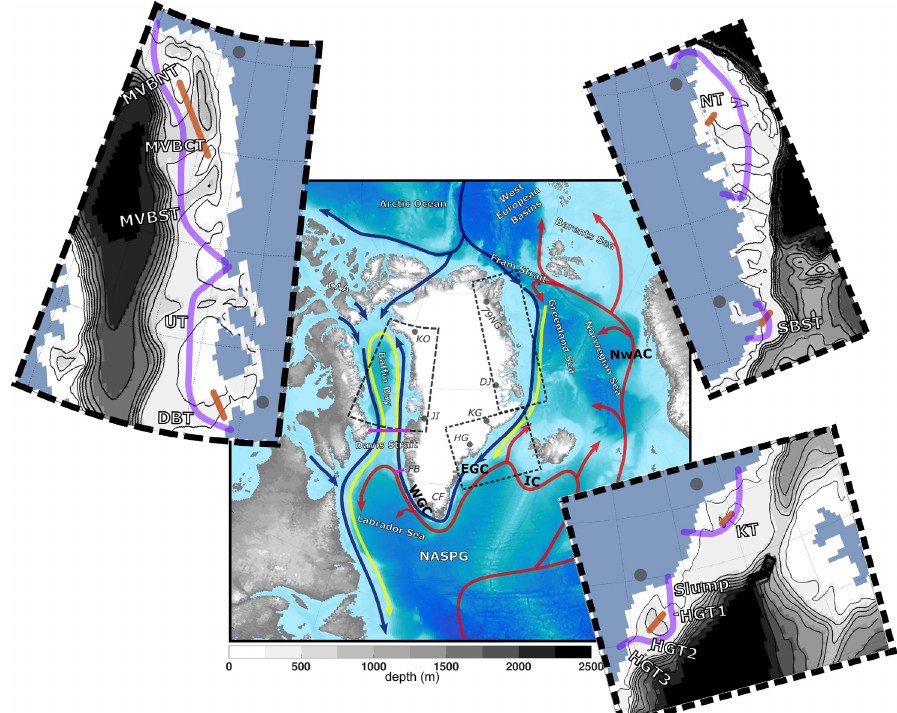
Figure 1. Ocean circulation around Greenland with relatively warm Atlantic waters is shown in red, modified Atlantic waters are shown in yellow, and the Arctic and freshwater pathways are shown as blue lines. The large map’s bathymetry and topography was generated using the ETOPO2 v2 dataset (National Geophysical Data Centre, 2006). This map shows areas that will be discussed throughout this study such as the North Atlantic Subpolar Gyre (NASPG), Labrador Sea, Davis Strait (section drawn in magenta), Baffin Bay, Canadian Arctic Archipelago (CAA), Arctic Ocean, West European Basins, Norwegian Sea, Greenland Sea, Fram Strait, Cape Farwell (CF), and Fylla Bank (FB) (section drawn in magenta). Ocean currents (adapted from Straneo et al., 2012; Hu and Myers, 2013) that will be discussed are shown here, Irminger Current (IC), Norwegian Atlantic Current (NwAC), East Greenland Current (EGC), and West Greenland Current (WGC). The light grey circles show the locations of six marine-terminating glaciers: Kong Oscar (KO) that terminates into Melville Bay (MVB), Jakobshavn Isbrae (JI) that terminates into Disko Bay (DB), Helheim Glacier (HG), Kangerlussuaq Glacier (KG), Daugaard-Jensen Glacier that terminates into Scoresby Sund (SBS), and Nioghalvfjerdsbrae (79NG). The insets show a closer view of specific regions around Greenland. Starting from the top left are the western, southeastern, and northeastern coasts. The insets show the model coastline, model bathymetry in metres (in grey shading and black contours), six sections of our analysis along the shelf in light purple, and sections of troughs (tan